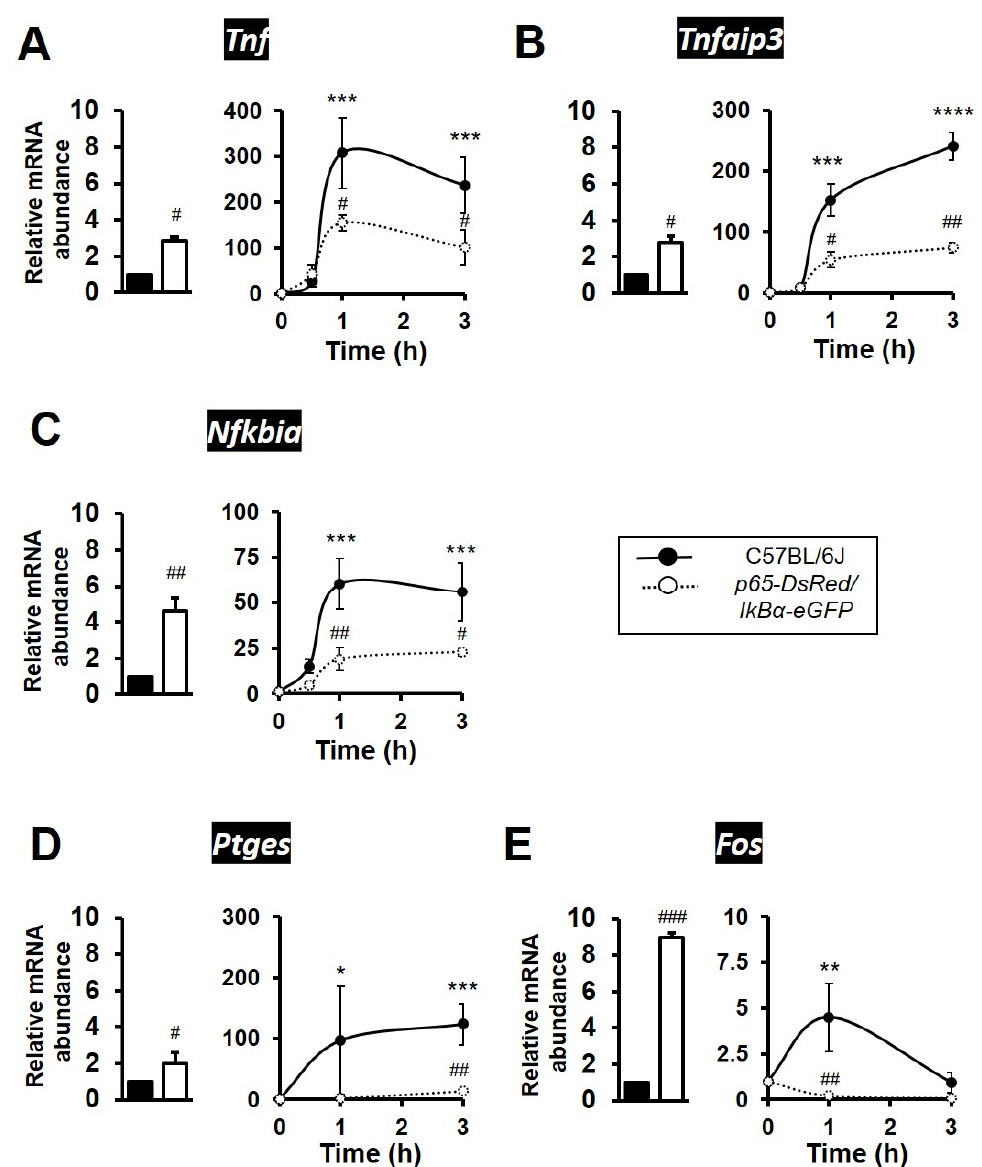
Figure 3. Expression of NF κ B target genes are markedly altered in expression in p65-DsRedxp/I κ B α - eGFP bone marrow-derived macrophages (BMDMs). Bone marrow cells from frozen stocks were differentiated in vitro to macrophages as described in Materials and Methods. Murine C57BL/6J and transgenic BMDMs were left unstimulated or were stimulated with LPS (100 ng/mL) for a time course of up to 3 h. Total RNA was purified, and the samples were analysed by qPCR for expression of NF κ B target genes ( A ) Tnf , ( B ) Tnfaip3 , ( C ) Nfkbia , ( D ) Ptges , and ( E ) Fos ; with the left hand panel showing a histogram of fold change in mRNA levels in untreated transgenic BMDMs (white bar) relative to C57BL/6J controls (black bar), and the right hand panel showing dynamic changes in gene expression following treatment with LPS relative to respective unstimulated control or transgenic BMDMs. Significant differences to unstimulated BMDMs, * p < 0.05, ** p < 0.01, *** p < 0.001 and **** p < 0.0001; or stimulated transgenic, # p < 0.05, ## p < 0.01 and ### p < 0.001 (Kruskal–Wallis test; n = 3 mice, n = 2–3